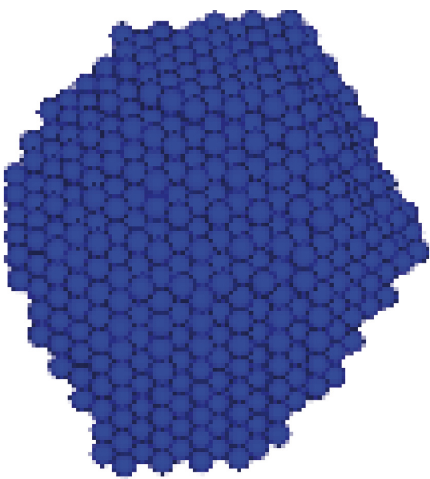
Figure 3: Irregular aggregate particles model.